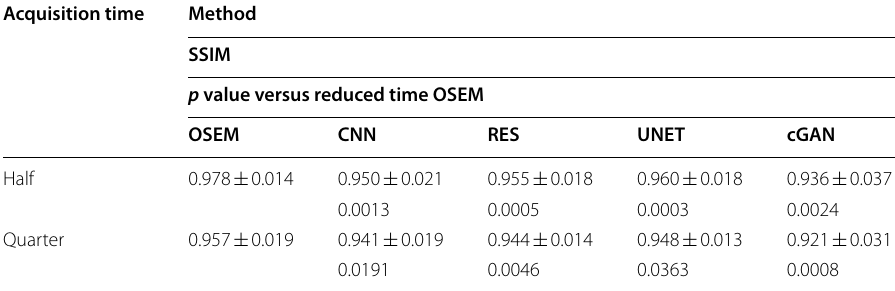
Table 4 Structural similarity index measure (mean different methods and acquisition times at